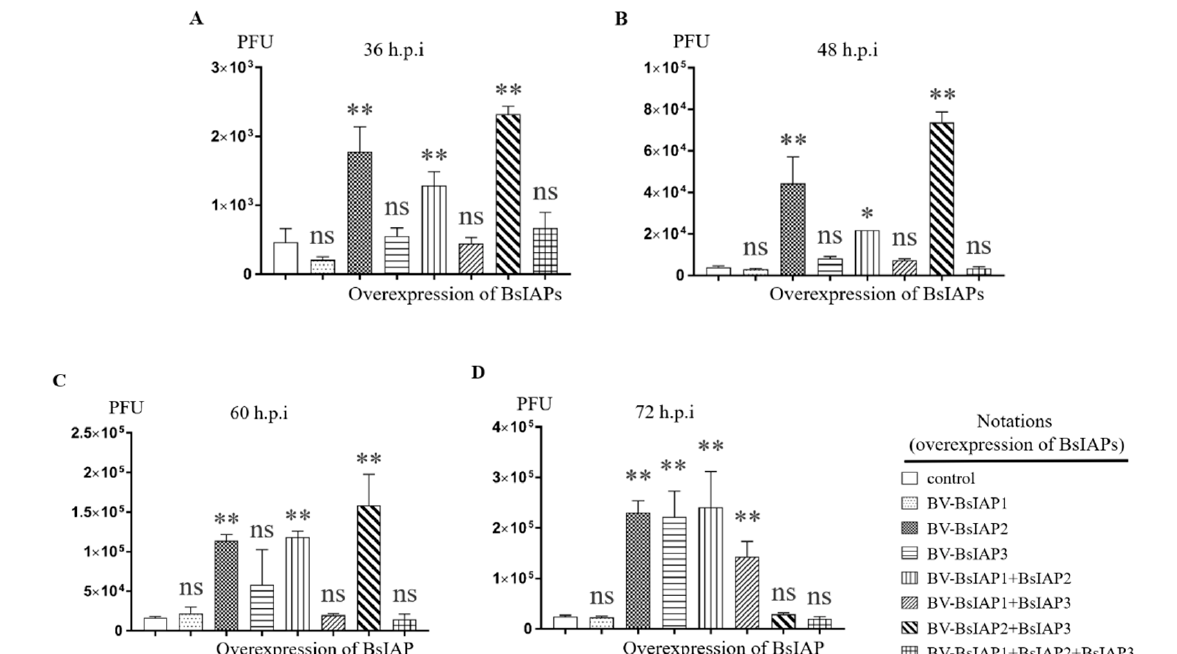
Figure 9. Effects of overexpression of BsIAPs on progeny virus titers after different infection time periods (* p < 0.05, ** p < 0.01). ( A ) Overexpression of BsIAPs for 36 h. ( B ) Overexpression of BsIAPs for 48 h. ( C ) Overexpression of BsIAPs for 60 h. ( D ) Overexpression of BsIAPs for 72 h. Control cells were infected with BV-gfp under the same operation.